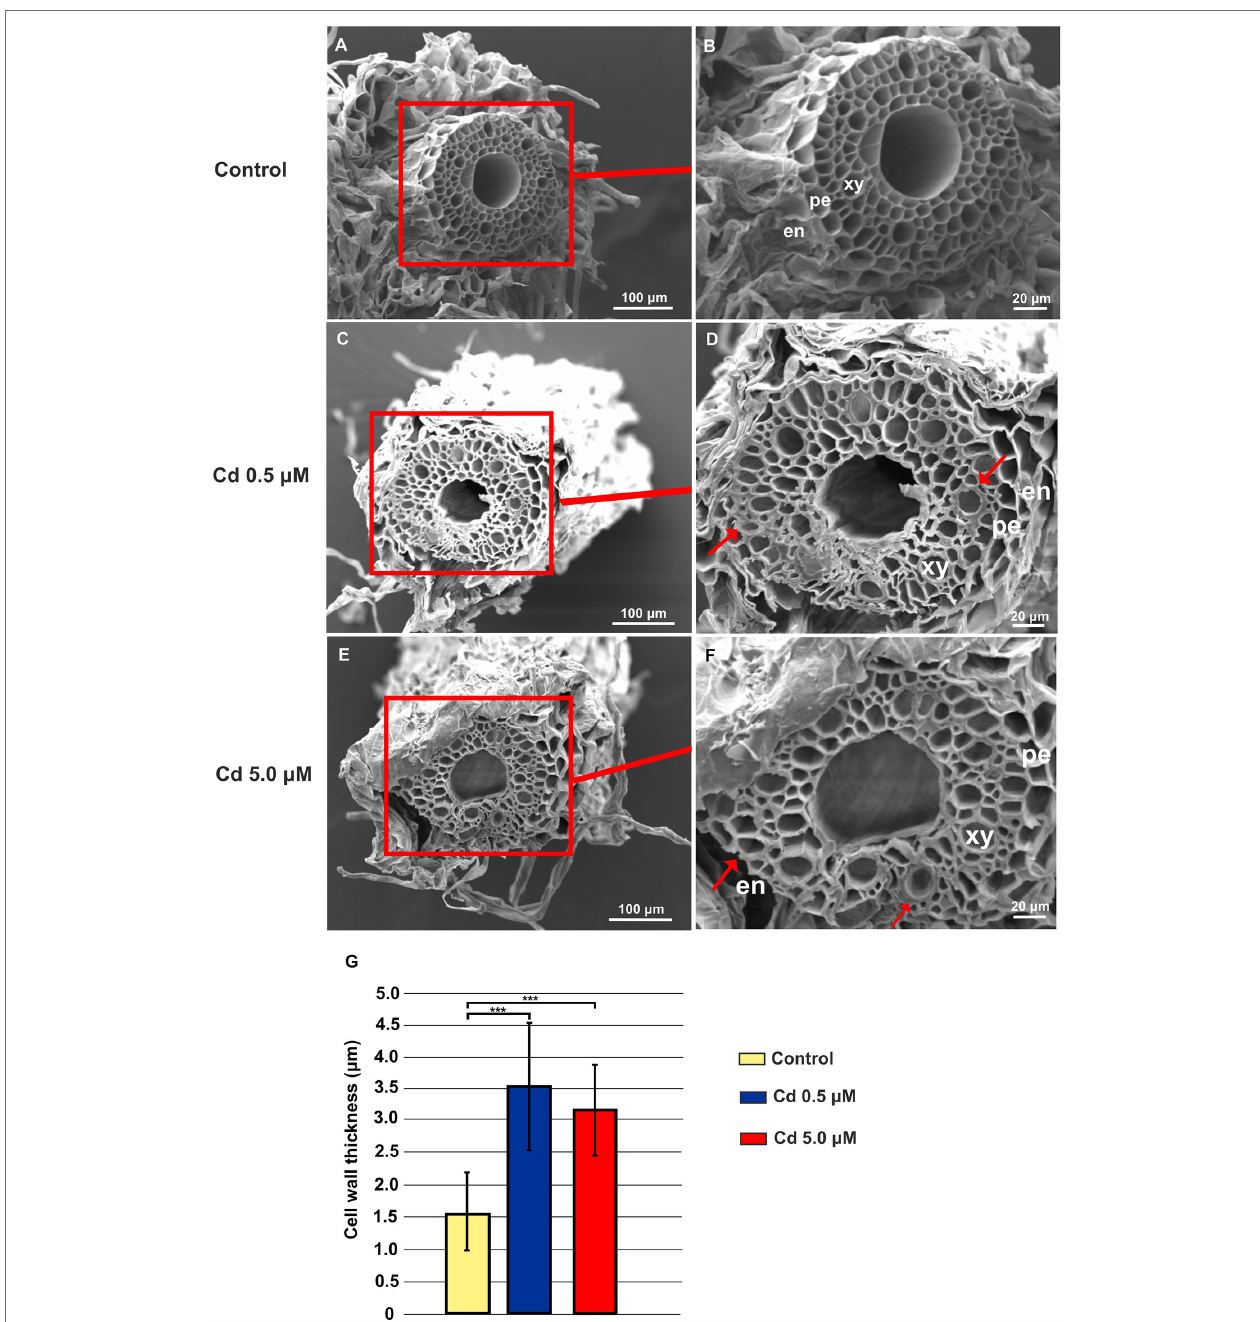
FIGURE 2 | Scanning electron microscope (SEM) microphotographs of root cross-sections obtained from plants grown for 15 days (starting from sprouting) in absence or presence of Cd (0.5 or 5.0 μ M). Panels (A) and (B) Root cross-sections in the control roots; panels (C) and (D) root cross-sections of plants grown in the presence of Cd 0.5 μ M; panels (E) and (F) root cross-sections of plants grown in the presence of Cd 5.0 μ M. en: endodermis; pe: pericycle; xy: xylem. Red arrows indicate pericycle and xylem cell wall thickening. (G) , cell wall thickness in the xylem vessels. Eight independent roots were assessed for each treatment (12 cross- sections for root). T -test p <